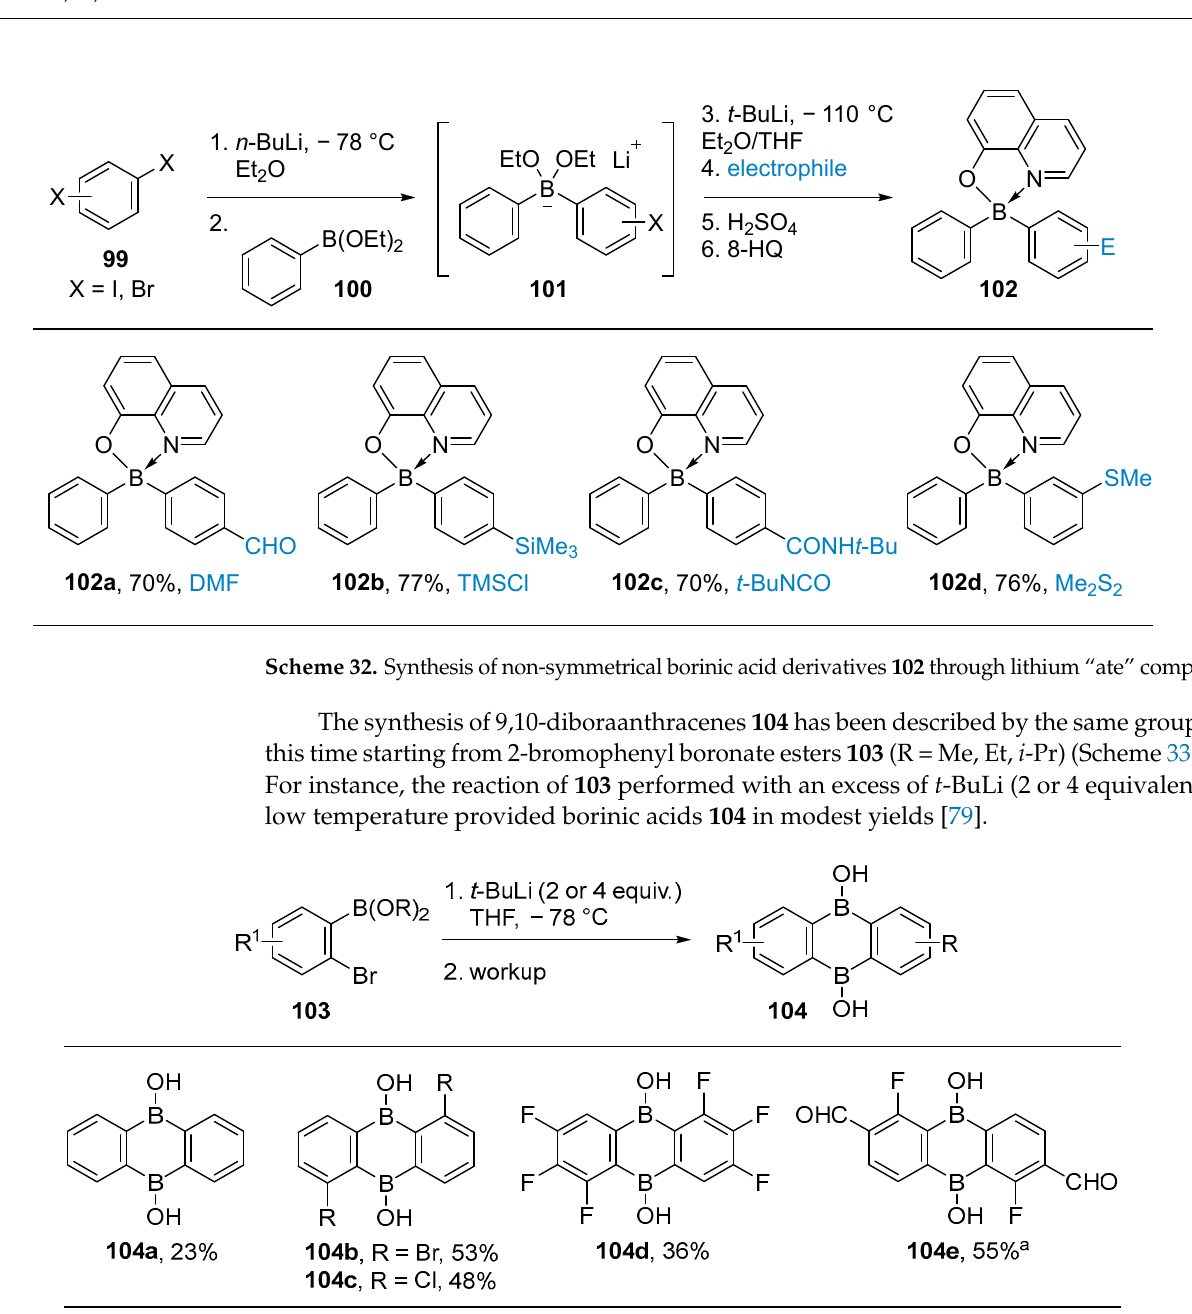
18 of 42 For example, the reaction tolerates aromatic rings substituted with methyl, aryl or amino groups ( 97a-c ) on the organometallic reagent 95 or the boronic acid partner 96 [17,71,72]. The addition of aryllithium onto heteroaromatic boronic esters also performs well, as shown with pyridine-substituted boron quinolate 98d obtained with a good yield [73,74]. Even more interesting is the possibility of incorporating an iodine atom such as in borinic acid 97e [75]. In brief, monolithiation of 1,4-diiodobenzene, followed by the addi- tion onto the corresponding boronic ester, led to 97e that can be further functionalized by Still coupling thanks to the remaining iodine substituent. This method was also used to prepare borinic acid 97f derived from coumarin, a new probe to monitor H 2 O 2 -mediated signaling processes [76]. Dihalogenobenzenes have also been used in the one-pot synthesis of functionalized non-symmetrical borinic acid derivatives (Scheme 32) [77]. In this approach, diiodo- or dibromo arenes 99 are treated with one equivalent of n -BuLi, then the corresponding